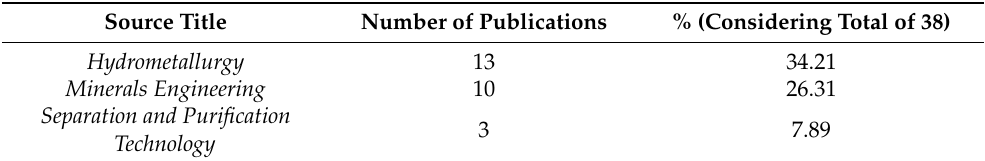
Table 2. Main journals where articles have been published considering glycine in leaching (data from 2018 to 2022).